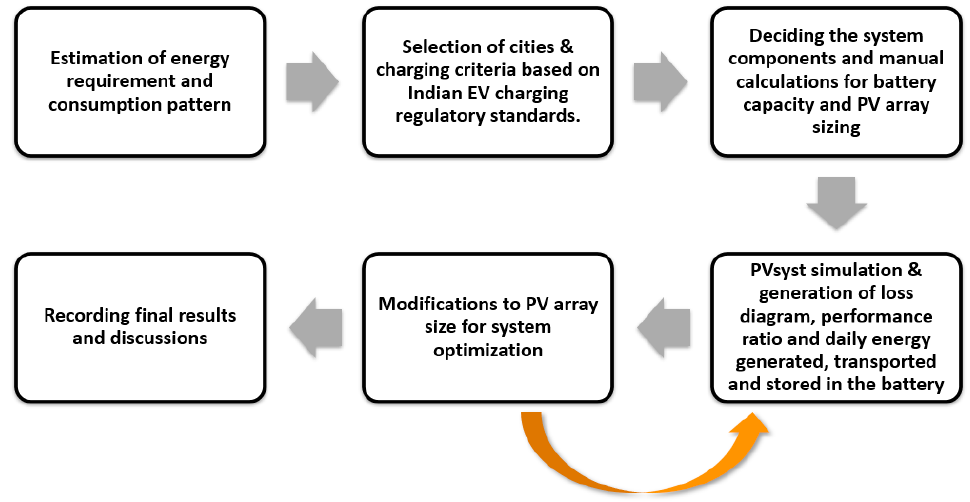
Figure 1. Methodology for PV system design .